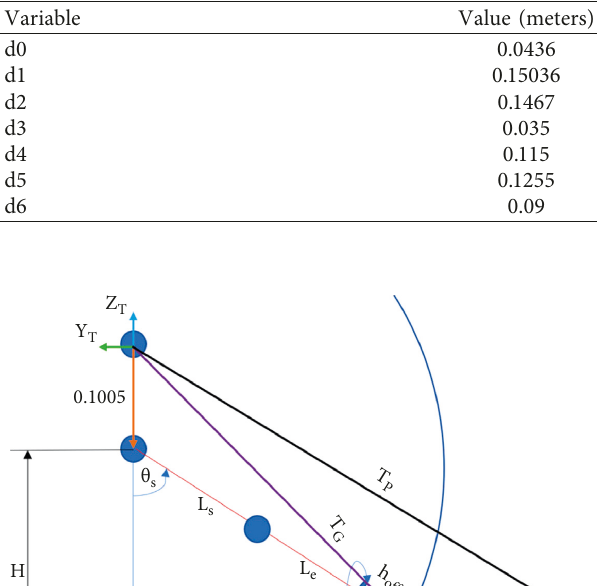
Figure 7: Distances from robot center. Table 1: Values of distances between frames.